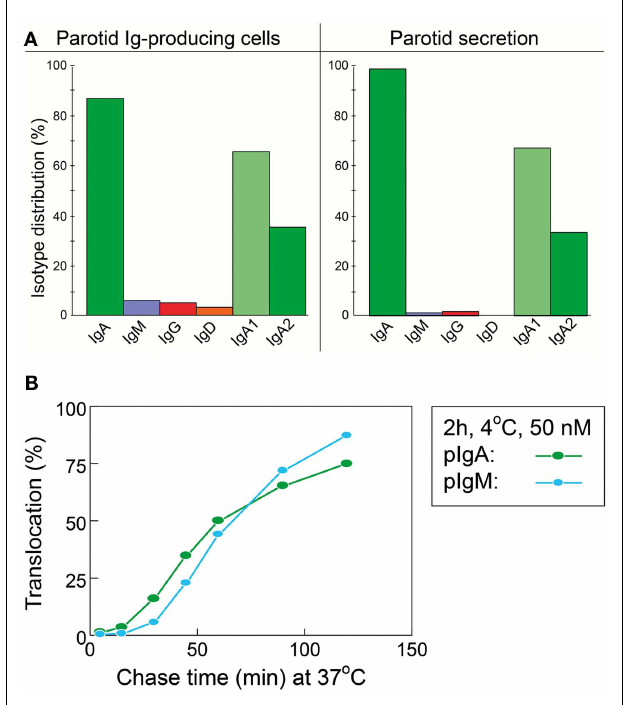
FIGURE 3 | Relationship between local production of Ig isotypes by gland-associated plasma cells and Ig transfer by secretory epithelium . (A) Compared with the local production in the parotid gland, export of IgA into stimulated secretion is clearly favored over export of IgM (and IgG and IgD), whereas translocation of the two subclasses of IgA appears to handled equally well by the glandular epithelium. (B) Comparison of epithelial translocation of dimeric IgA (pIgA) and pentameric IgM (pIgM) was performed in vitro with polarized MDCK cells transfected with the human polymeric Ig receptor. Cells were incubated with 125 I-labeled pIgA or pIgM for 2h at 4°C, washed for 10min at 4°C, and chased at 37°C for different times as indicated.Translocation is expressed as the cumulative appearance of 125 I-pIgA and 125 I-pIgM in the apical medium. Each point represents mean result of three filters for pIgA and pIgM translocation at 50nM ligand concentration. Adapted from Norderhaug et al.